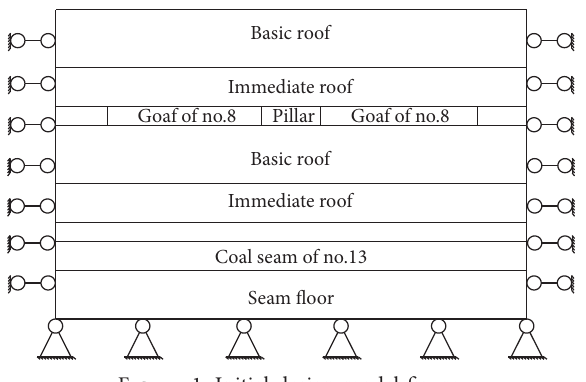
Figure 1: Initial design model